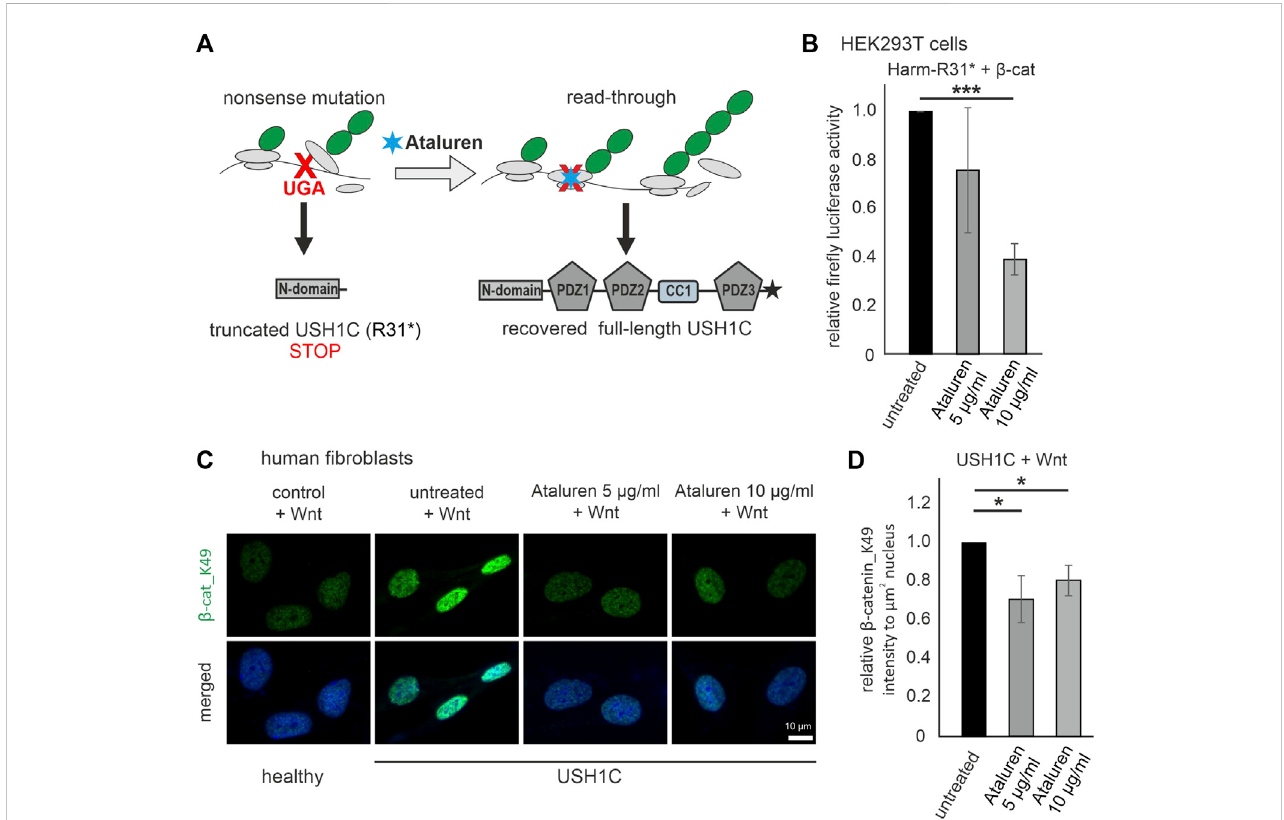
FIGURE 7 Treatment with Ataluren rescues cWnt in USH1C /harmonin-de fi cient cells. (A) Scheme of translational read-through of premature termination codons. Ataluren (blue asterisk) enhances translational read-through of the premature stop codon UGA (red) resulting in expression of full-length harmonin. (B) cWnt response in harmonin a1_R31*-GFP (Harm-R31*) and β -catenin ( β -cat) transfected HEK293T cells measured by TCF/LEF luciferase activity. Treatment with 5 μ g/mL and 10 μ g/mL Ataluren shows signi fi cant reduction of cWnt response in Harm-R31* transfected cells. DMSO in all cells at 0.2%. Two-tailed Student ’ s t -tests, *** p ≤ 0.001; N = 3 experiments (three triplicates each condition). (C) Immuno fl uorescence analysis reveals signi fi cant decrease of β -cat_ K49 (green) in Wnt stimulated USH1C ( USH1C R31*/R80Pfs*69 ) patient-derived fi broblasts after treatment with Ataluren (5, 10 μ g/mL). The nucleus is marked with DAPI (blue). (D) Levels of β -cat_K49 were decreased by 0.3 (5 μ g/mL) and 0.2 (10 μ g/mL) in Ataluren treated cells. DMSO in all cells at 0.2%. Two-tailed Student ’ s t -tests, * p ≤ 0.05; N = 3 experiments, cell number: untreated, n = 246; Ataluren 5 μ g/mL, n = 349 cells; 10 μ g/mL, n =